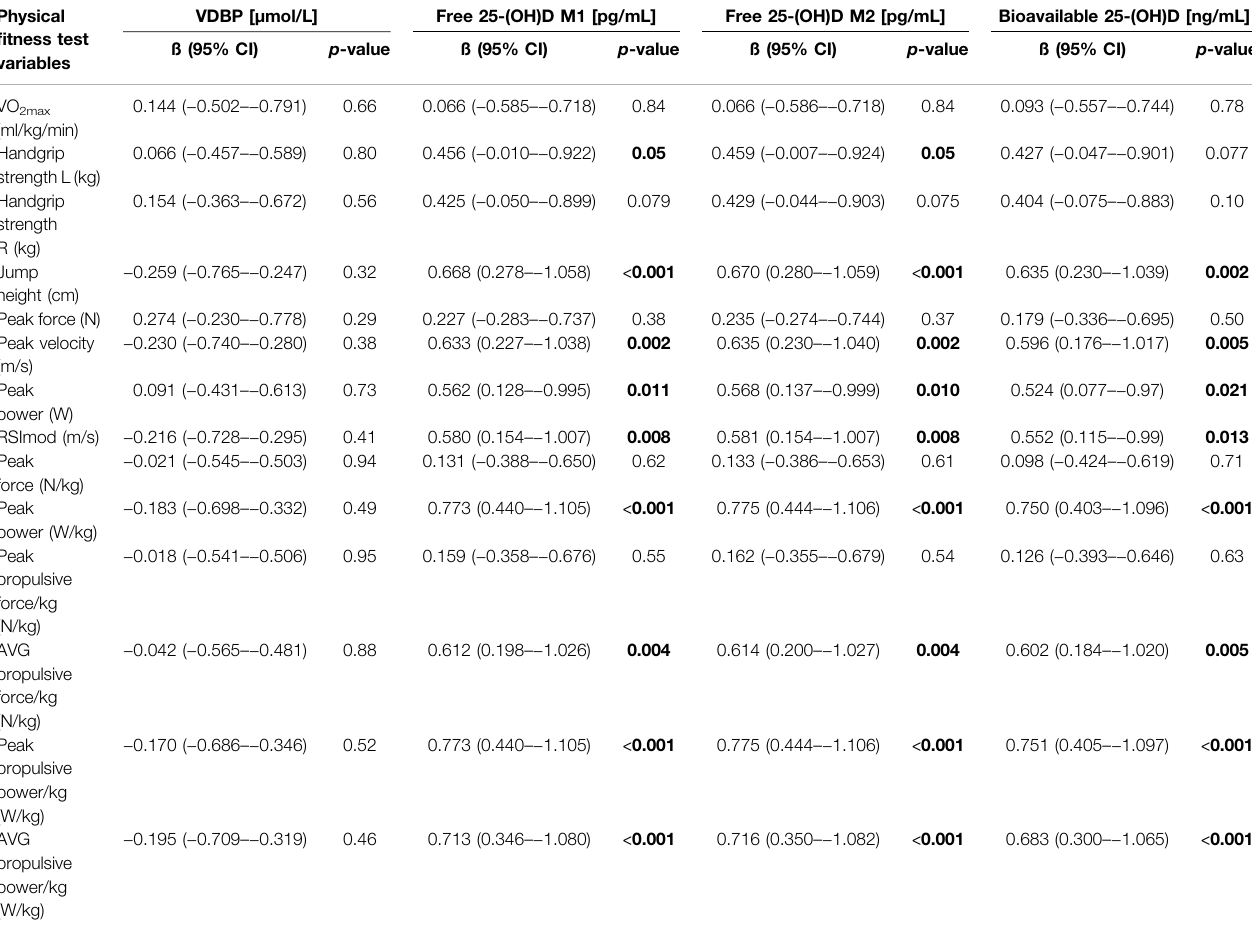
TABLE 4 | Association of athletic performance with VDBP, free, and bioavailable 25-(OH)D concentration by multiple regression analyses* in indoor players ( n = 16). Physical fi tness